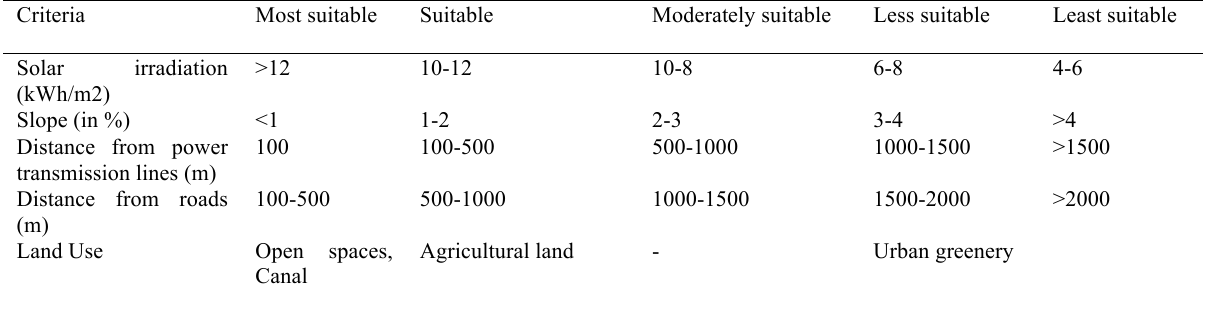
Table 1 . Datasets used in this study and their description